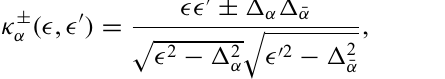
0; upward diagonal arrow in Fig. 2(d)], or charge-parity jumps [ | ω | (cid:11) ω , also known as parity-switching events; 10 horizontal arrow in Fig.